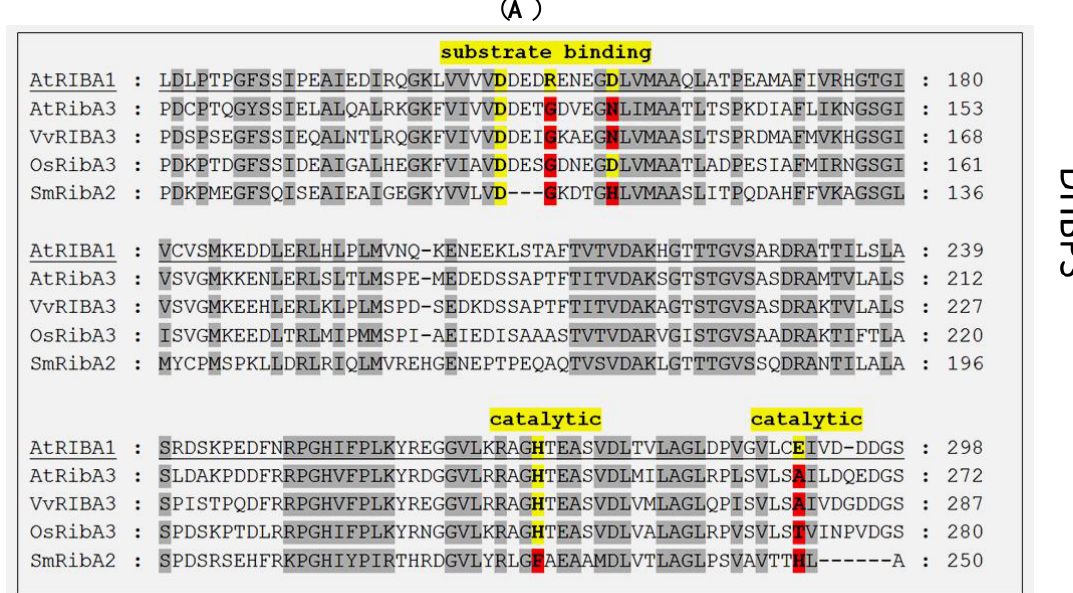
Figure S1. Comparison of RIBA3 clade members. Partial alignments of RIBA3 clade members with bifunctional AtRIBA1 (underlined). Enzymatically important amino acid residues for DHBPS ( A ) and GCHII ( B ) function are highlighted in yellow. Substitutions in catalytic or substrate binding domains of the different RIBA3 sequences are marked in red. The loss of essential amino acids is restricted to DHBPS regions. This classifies all members of the RIBA3 clade as monofunctional enzymes possessing GTP cyclohydrolase II activity only. Important residues and domains for both enzymes have been